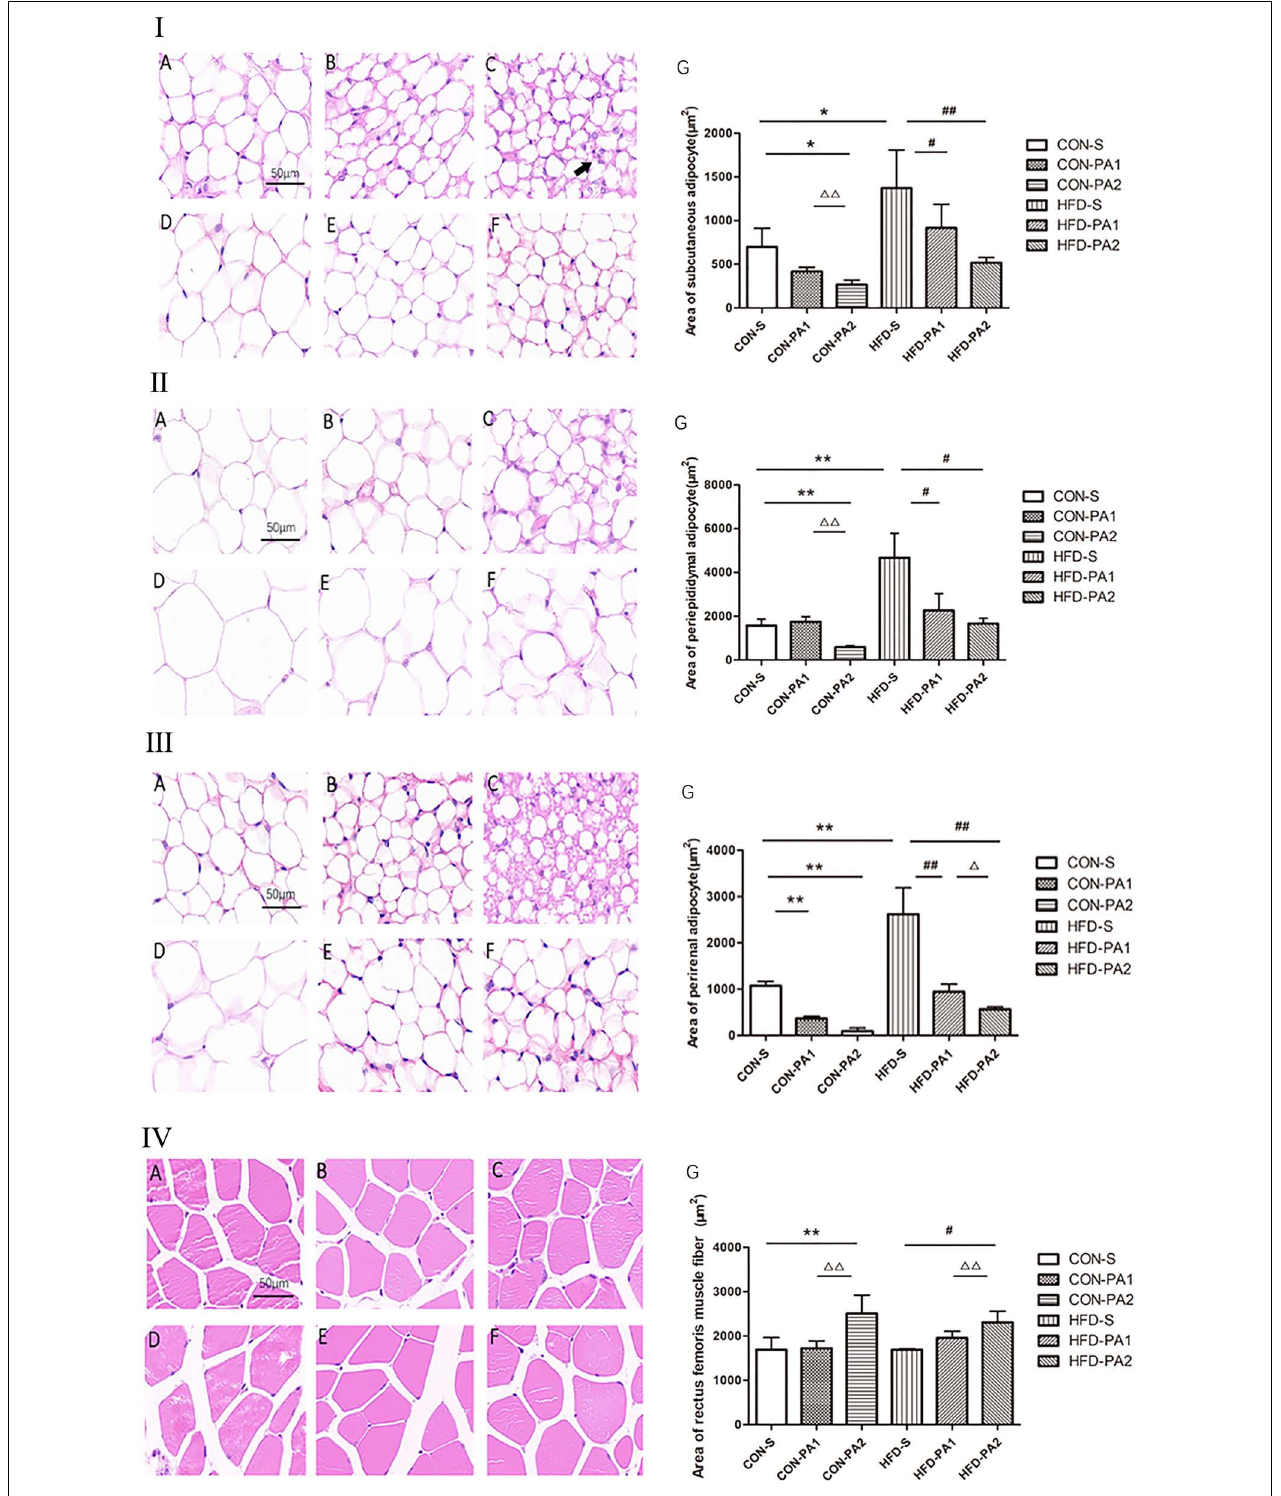
FIGURE 2 | HE staining analysis of adipose tissue and skeletal muscles of mice. (I) Subcutaneous adipocytes. (II) Epididymal adipocytes. (III) Perirenal adipocytes. (IV) Skeletal muscle cells. (A) CON-S group. (B) CON-PA1 group. (C) CON-PA2 group. (D) HFD-S group. (E) HFD-PA1 group. (F) HFD-PA2 group. (G) Area comparison of adipocytes and skeletal muscle cells in each group. Compared with the CON-S group, * P < 0.05 and ** P < 0.01; compared with the HFD-S group, # P < 0.05 and ## P < 0.01; comparison between exercise groups (CON-PA1 vs. CON-PA2, HFD-PA1 vs. HFD-PA2), (cid:49) P < 0.05 and (cid:49)(cid:49) P < 0.01.